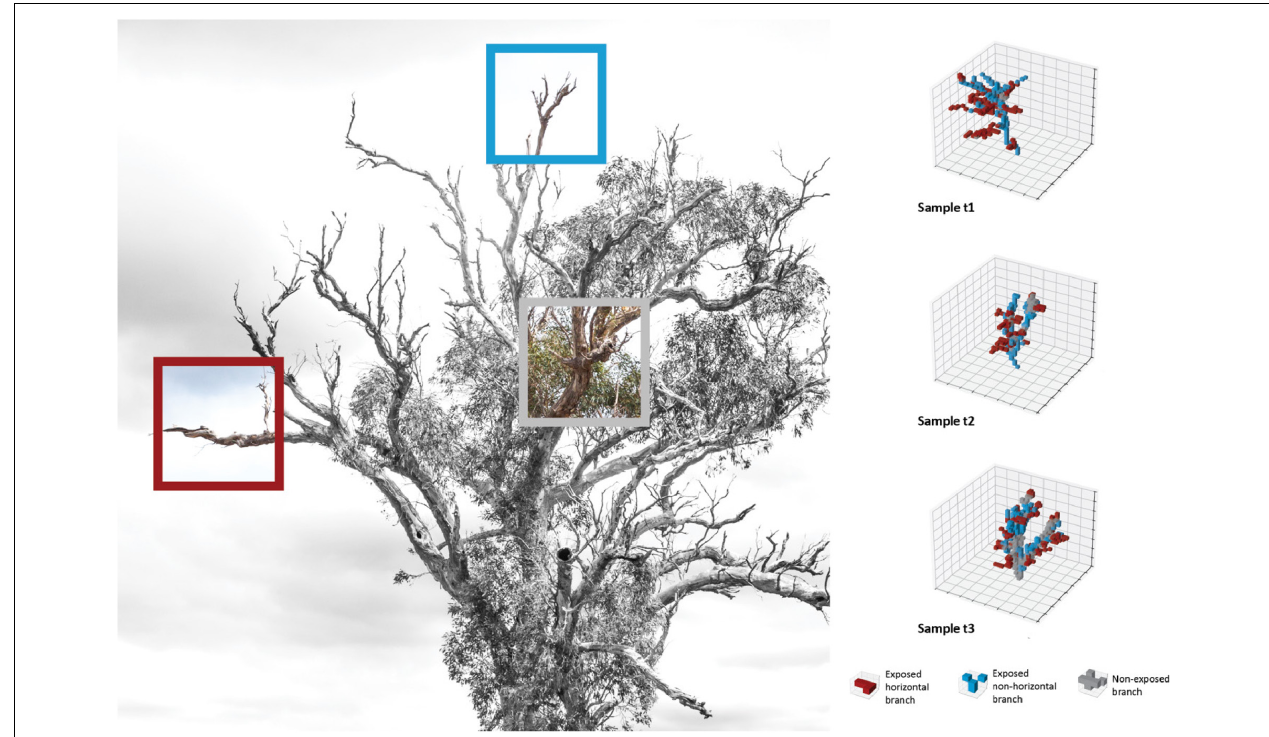
FIGURE 4 | Segmentation of 32 × 32 × 32 voxel representations. (Left) Select branch types in a large old tree. (Right) 3D segmentation of the sample tree